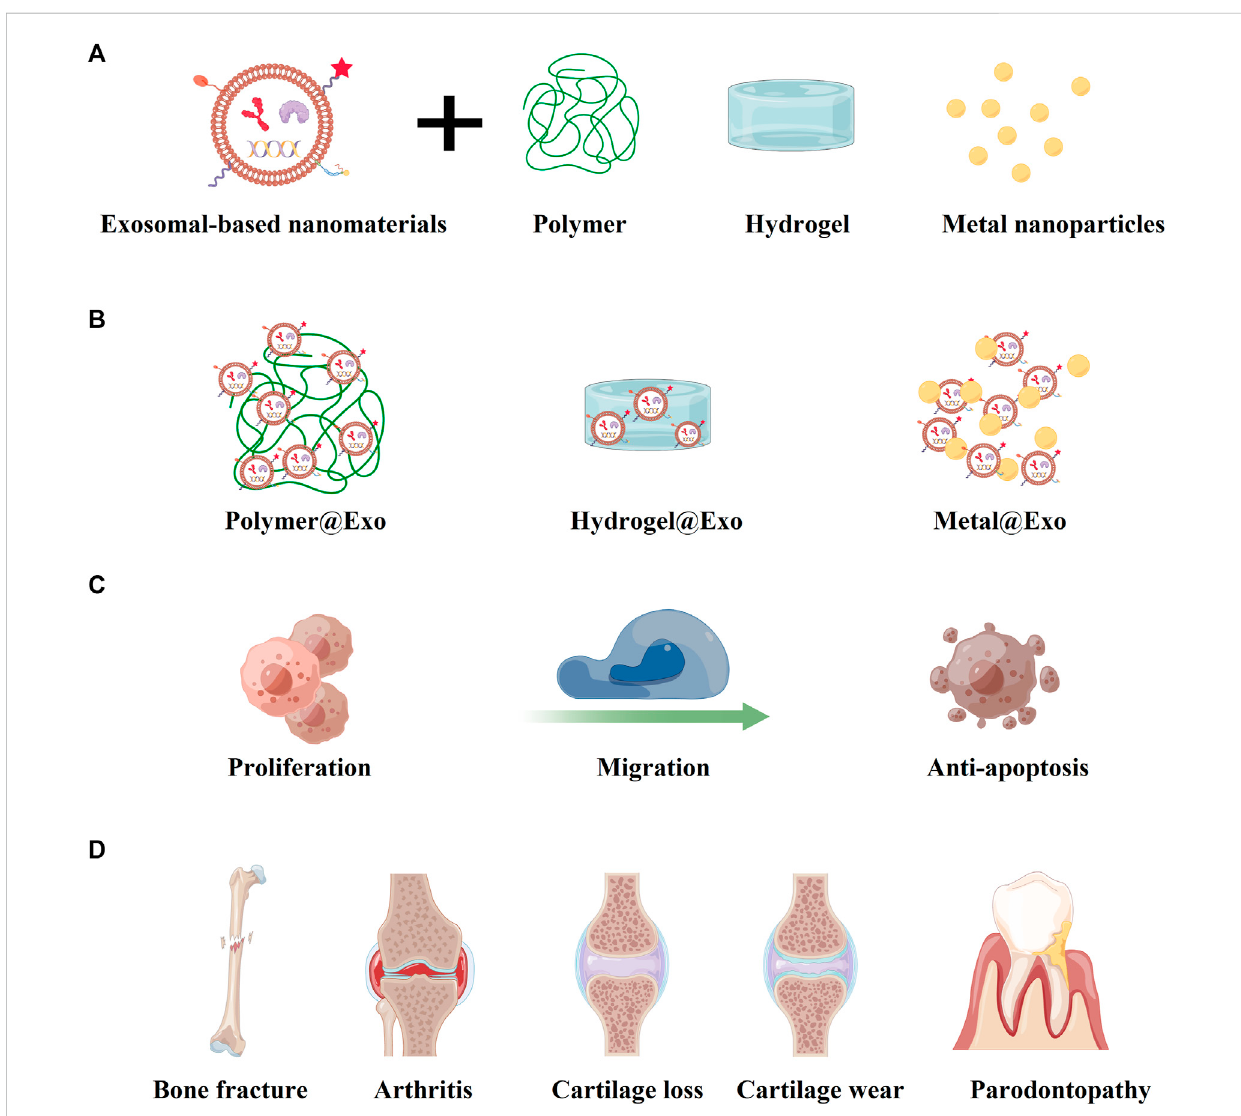
FIGURE 4 Multiple biologicalapplications ofexosomal-based nanomaterials bycombining with othermaterials. (A) Theexosomal-based nanomaterials could combine with polymer, hydrogel, and metal nanoparticles. (B) The formations of exosomal-based complexes of polymer@Exo, hydrogel@Exo, and metal@Exo. (C) Various exosomal-based complexes possess the improved capacities of proliferation, migration, and anti-apoptosis. (D) The bone and cartilage conditions in the limelight of exosomal-based